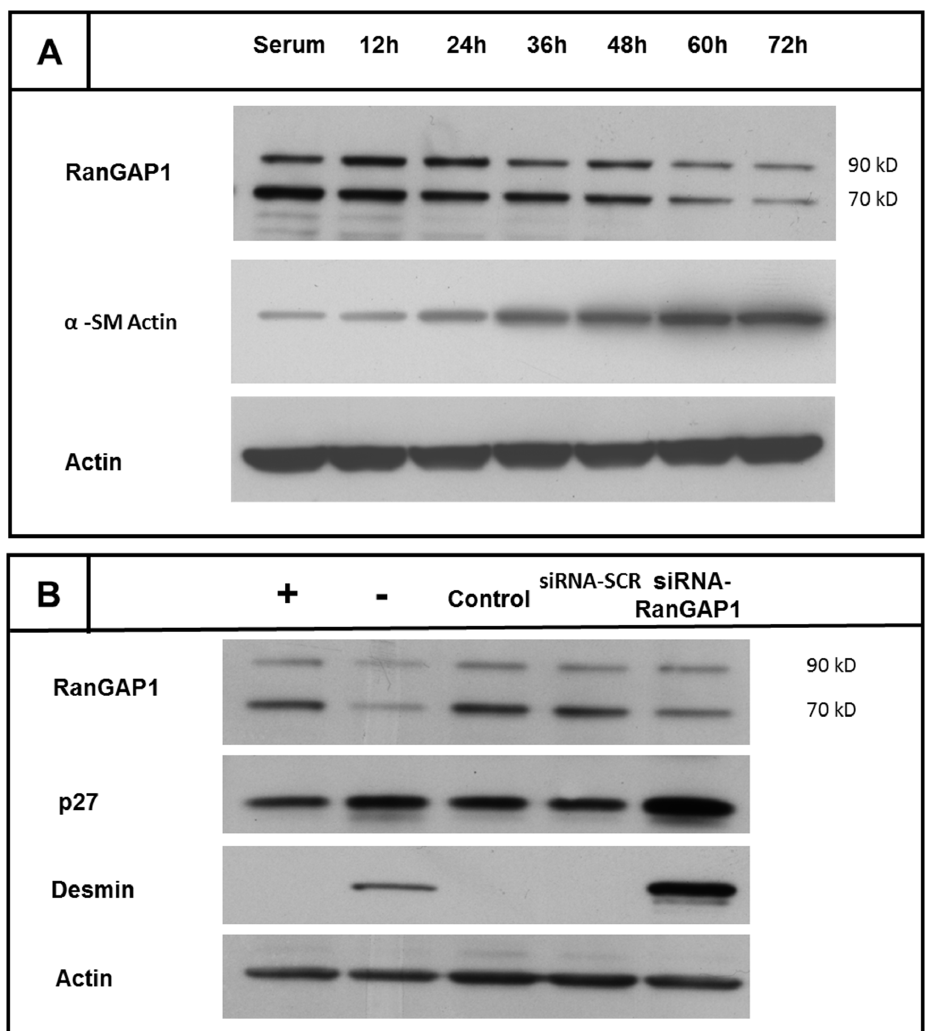
Figure 1. Downregulation of RanGAP1 in arrested, differentiated smooth muscle cells (A). To induce differentiation, CASMCs were depleted from serum. RanGAP1 expression in CASMC was assessed by Western Blotting 12 h, 24 h, 36 h, 48 h, 60 h and 72 h thereafter. The monoclonal antibody both detects the unmodified ( , 70 kDa) form as well as the SUMO-1 conjugated ( , 90 kDa) form of the RanGAP-1 protein. Both bands revealed reduced RanGAP1 expression over time in cells entering quiescence. a -SM Actin protein, a marker of cell differentiation, is increased over time. Actin levels are displayed as loading control. Effect of posttranscriptional gene silencing of RanGAP1 by small interfering RNA (siRNA) on cell cycle and differentiation markers (B). siRNA mediated gene silencing of RanGAP1 was able to reduce the 90 kD band by 31.8 6 21.2% (90 kD band) and 75% 6 14.7% (70 kD band) 48 h post transfection, respectively (average of three different experiments). RanGAP1 depletion was associated with a strong increase of p27 Kip1 expression by 60 6 34%. RanGAP1 deficiency was also associated with a sharp increase in desmin expression with levels even higher than in quiescent cells. CASMC denotes coronary artery smooth muscle cells; ( + ) denotes serum stimulated CASMC; ( 2 ) denotes quiescent CASMC ( $ 72 h serum depletion); ‘‘control’’ denotes oligofectamine transfected cells without siRNAs; siRNA-SCR denotes scrambled (control) siRNA.